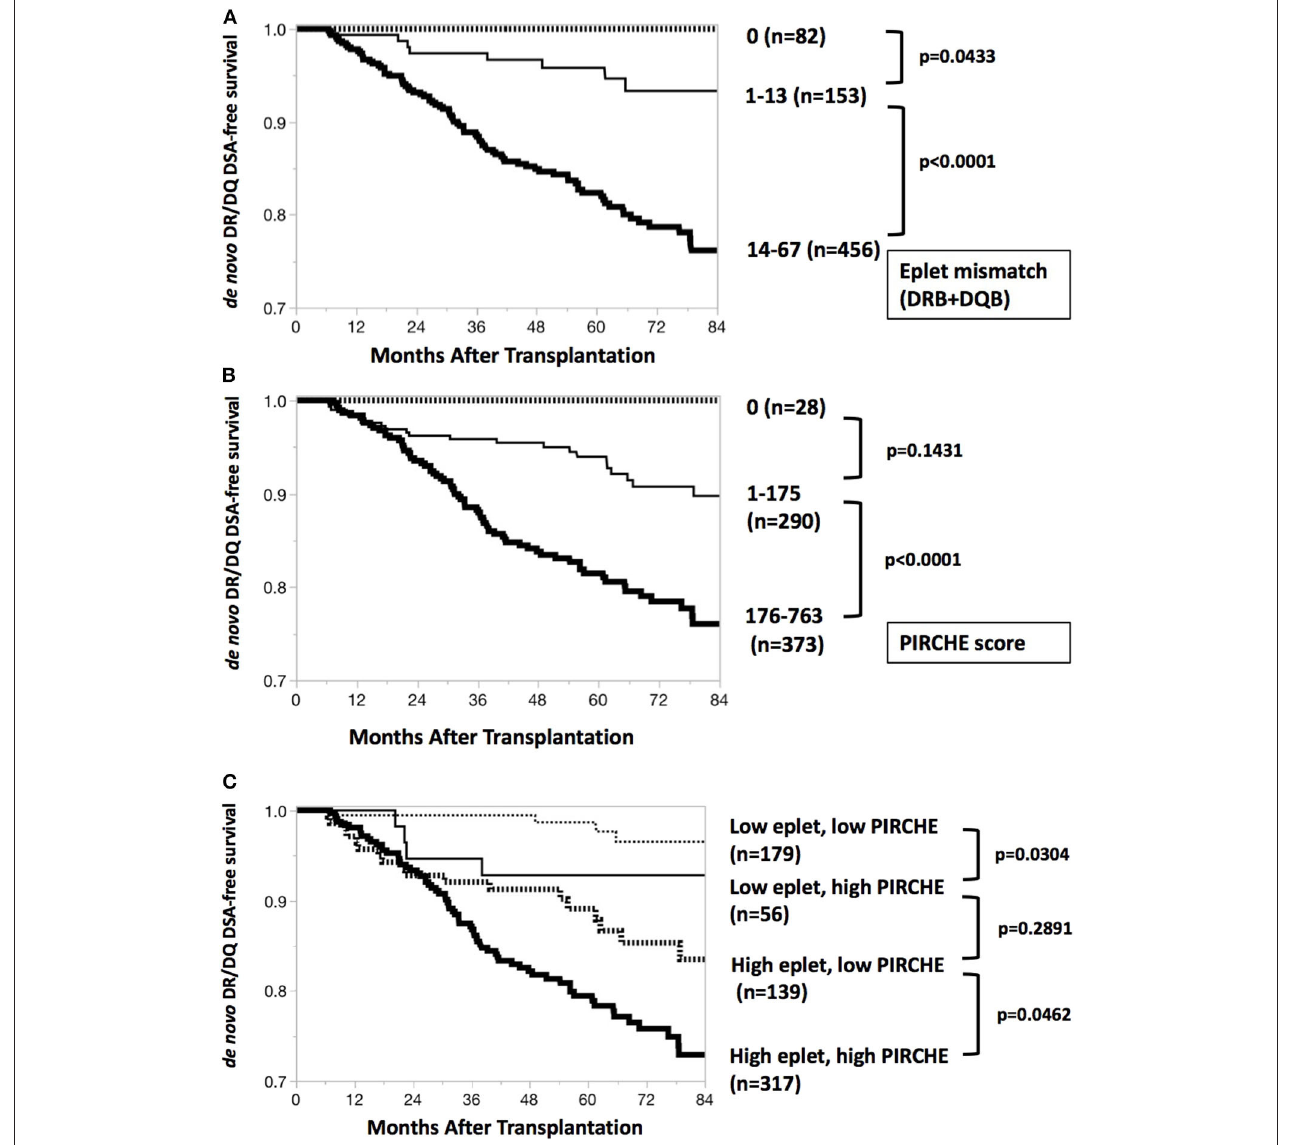
FIGURE 2 | De novo DR/DQ DSA-free survival curves. (A) De novo DR/DQ DSA-free survival by eplet mismatch. Kaplan-Meier de novo DR/DQ-free survival curves and Wilcoxon test show significant difference ( p < 0.0001) between epitope mismatches 1–13 and 14–67. Thick dotted line, thin black line and thick black line indicate DSA-free survival (months after transplantation) of groups with eplet mismatches 0, 1–13, and 14–67, respectively. (B) De novo DR/DQ DSA-free survival by PIRCHE score. Kaplan-Meier de novo DR/DQ-free survival curves and Wilcoxon test show significant difference ( p < 0.0001) between PIRCHE scores 1–175 and 176–763. Thick dotted line, thin black line and thick black line indicate DSA-free survival (months after transplantation) of groups with PIRCHE scores 0, 1–175, and 176–763, respectively. (C) De novo DR/DQ DSA-free survival by both eplet mismatch and PIRCHE score. Subgroup analysis by Kaplan-Meier de novo DR/DQ-free survival curves and Wilcoxon test shows significant differences between low and high PIRCHE scores among patients with low eplet mismatches ( p = 0.0304) and high eplet mismatches ( p = 0.0462). Thin dotted line, thin black line, thick dotted line and thick black line indicate DSA-free survival (months after transplantation) of groups including low eplet + low PIRCHE, low eplet + high PIRCHE, high eplet + low PIRCHE, and high eplet + high PIRCHE, respectively. Low eplet mismatches = 0–13; high eplet mismatches = 14–67; low PIRCHE scores = 0–175; high PIRCHE scores = 176–763.